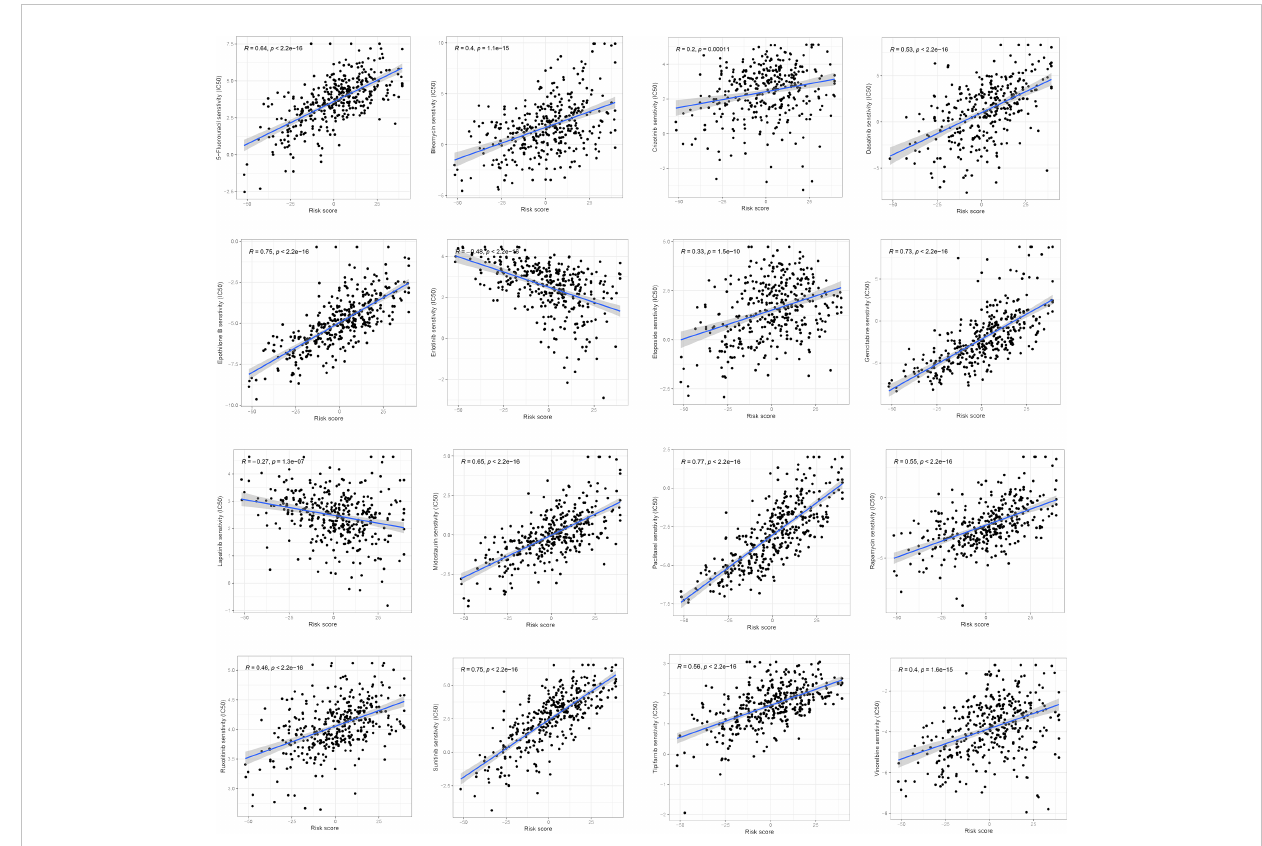
FIGURE 9 Correlation of ferroptosis scores with chemotherapeutic drug